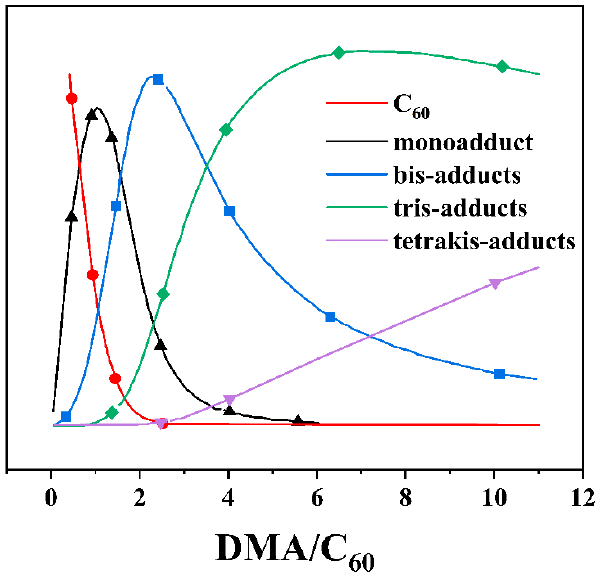
Figure 4. Distribution of C 60 and C 60 (DMA) n at different ratios of DMA/C 60 . The initial concentrations of H 2 @C 60 and DMA are 5 mM and 4.74 mM, respectively.